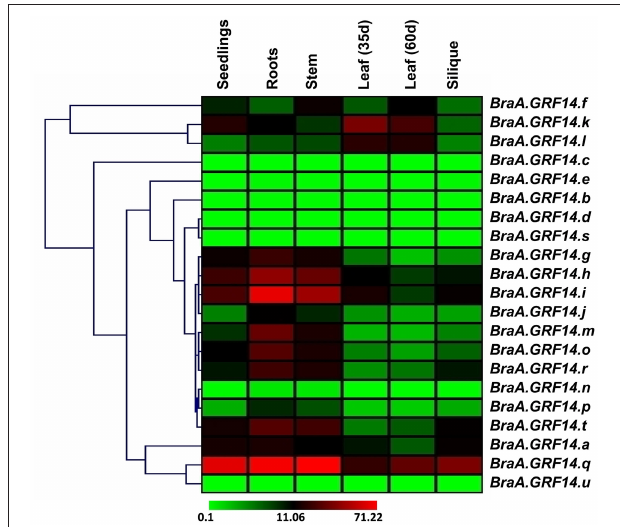
FIGURE 3 | Expression profile of B. rapa 14-3-3 genes ( BraA.GRF14 ) across plant developmental stages. A heat map representing hierarchical clustering of average fold values of BraA.GRF14 genes expression (w.r.t. GAPDH , set at 100) in various developmental tissues (mentioned at the top of each lane) is shown. The color scale representing average signal is shown at the bottom of the heat